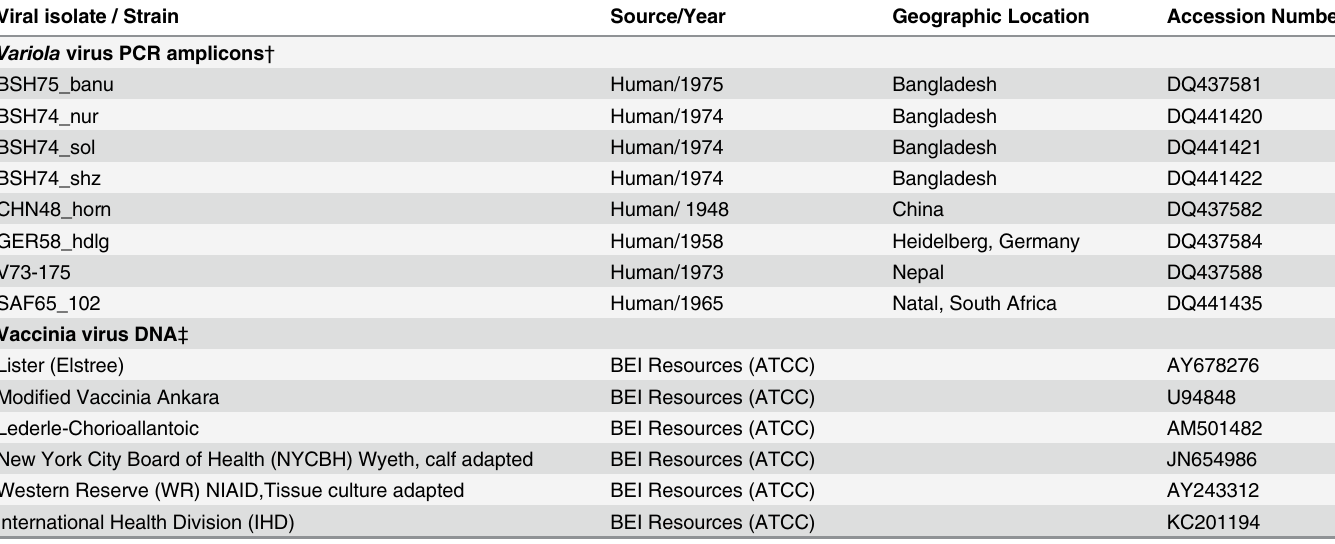
Table 2. Details of viral cultures and nucleic acids used in the study: DNA viruses. Viral isolate /